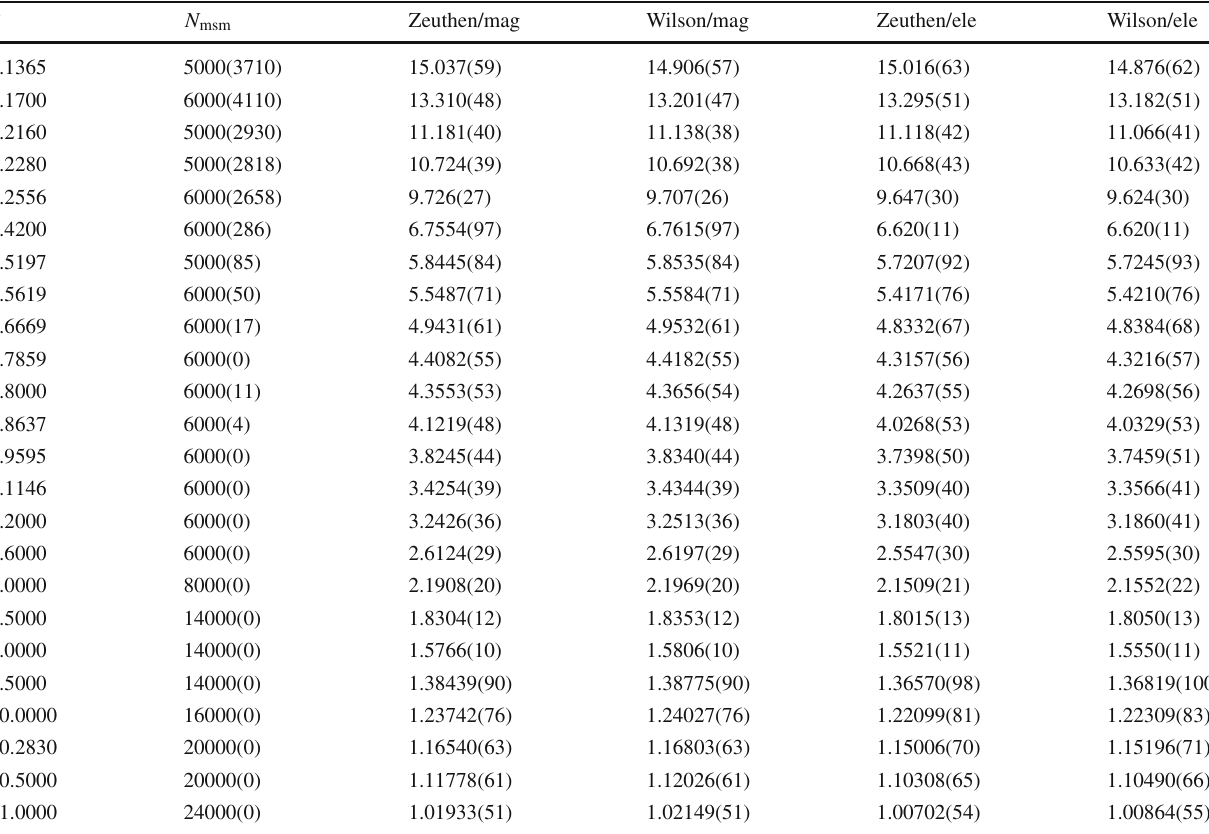
Table 12 GF coupling data for L / a = 20